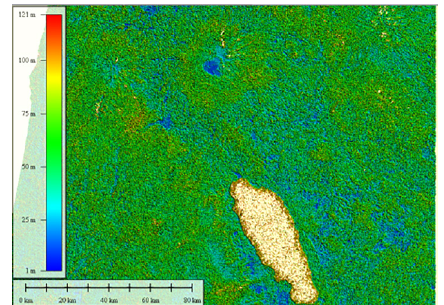
Figure 12. DSM conversion (vegetation height)